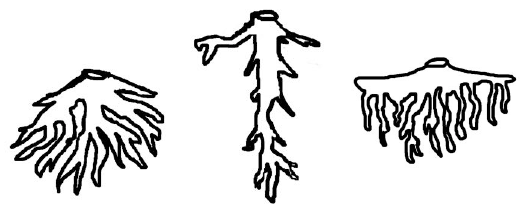
Figure 6. Author's artistic impression of the considered root systems. From left to right: Hearth root, Taproot, and surface- root